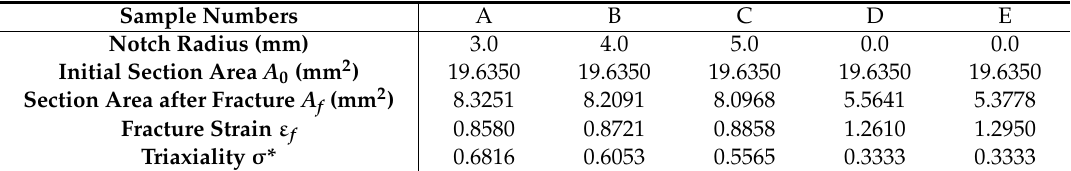
Table 5. Tensile samples measurement